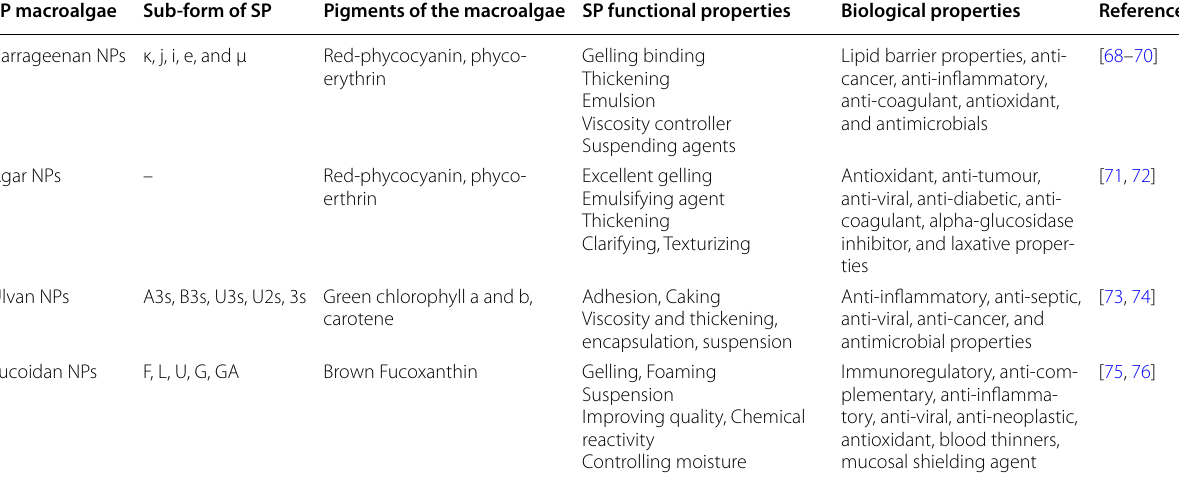
Table 2 Sulphate polysaccharide (SP)-based nanomaterial and their functions and biological properties SP macroalgae Sub-form of SP Pigments of the macroalgae SP functional